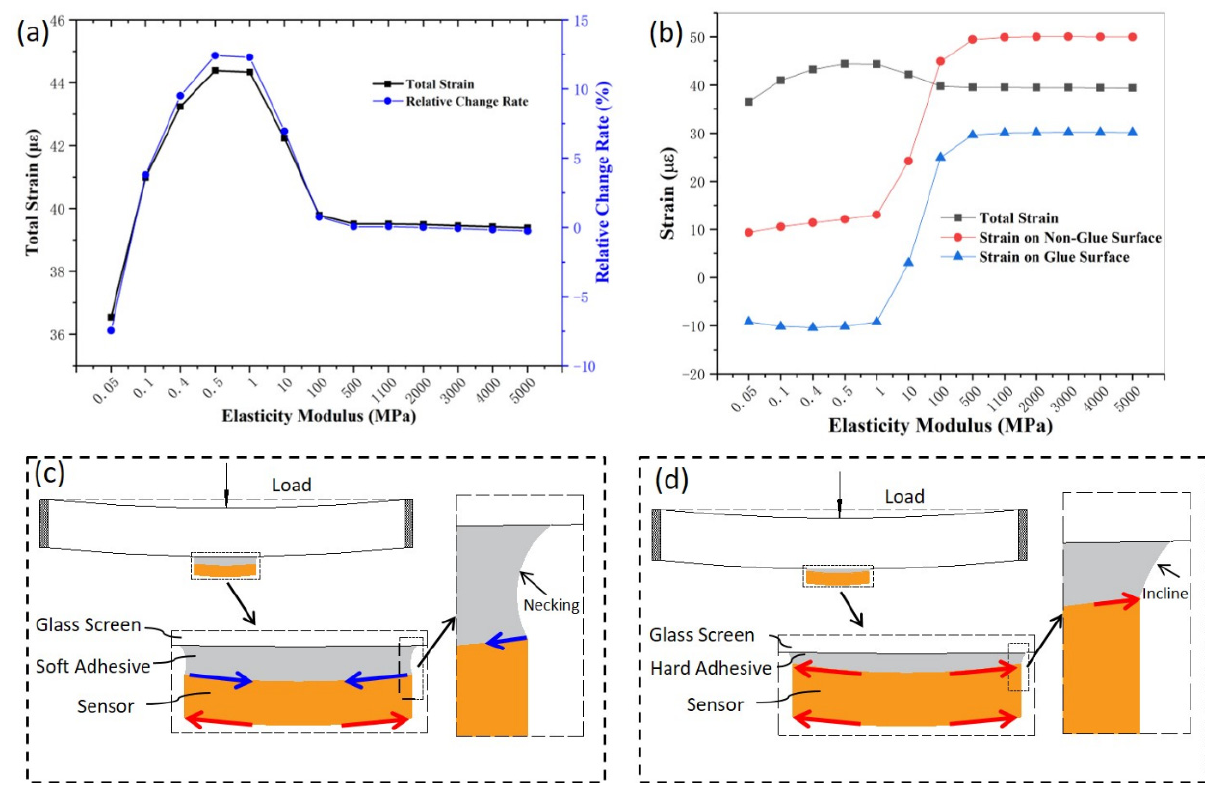
Figure 5. ( a ) Total strain output and relative rate of change versus the elastic modulus of the adhesive; ( b ) total strain, strain on the Non-Glue (non-adhesive) surface, and strain on the Glue (adhesive) surface versus the elastic modulus of the adhesive; ( c ) schematic of the force deformation of the low elastic modulus adhesive model; ( d ) schematic of the force deformation of the high elastic modulus adhesive model.